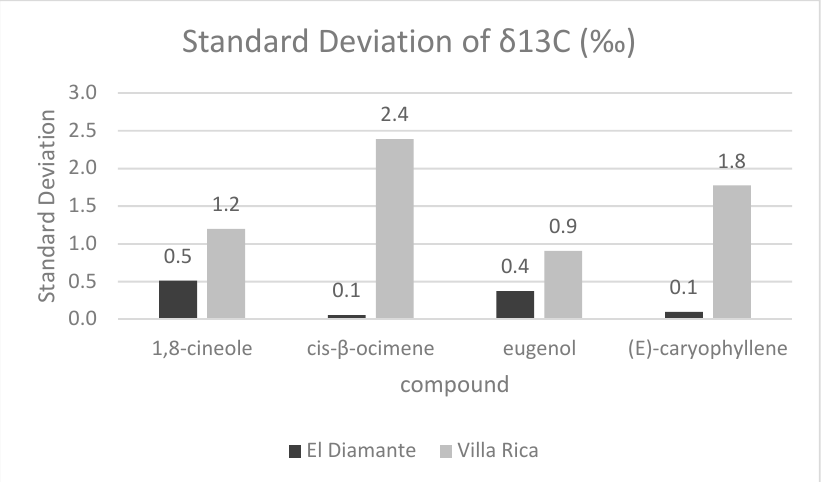
Figure 2. Standard deviations of δ 13 C values for 1,8-cineole, cis - β -ocimene, eugenol, and ( E )-caryophyllene for two regions, El Diamante and Villa Rica.